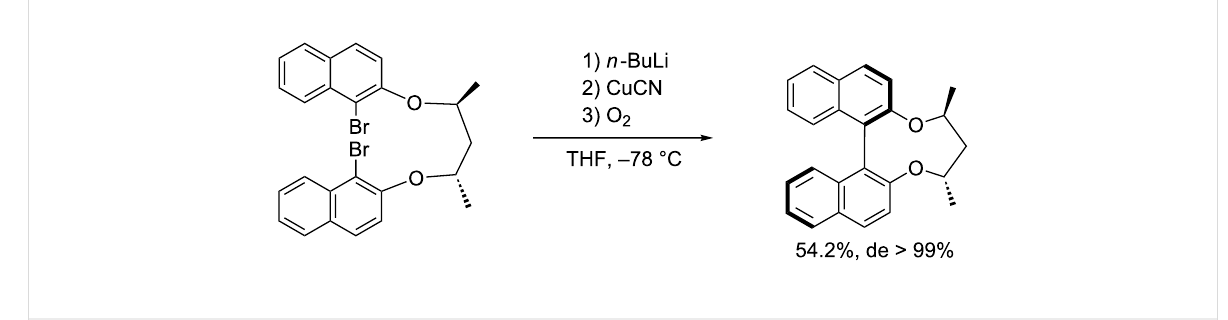
Scheme 12: Chiral 1,3-diol-derived tethers in the diastereoselective synthesis of biaryl compounds.